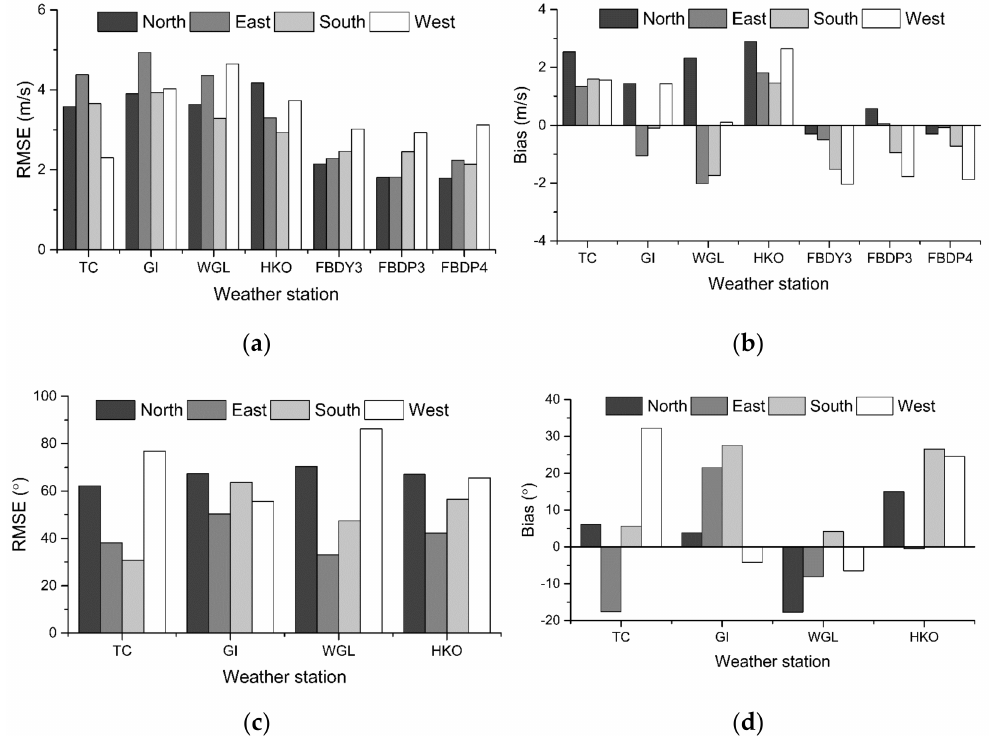
Figure 12. Wind speed and direction error variation as a function of the θ 10 . ( a ) RMSE of wind speed; ( b ) Bias of wind speed; ( c ) RMSE of wind direction; ( d ) Bias of wind